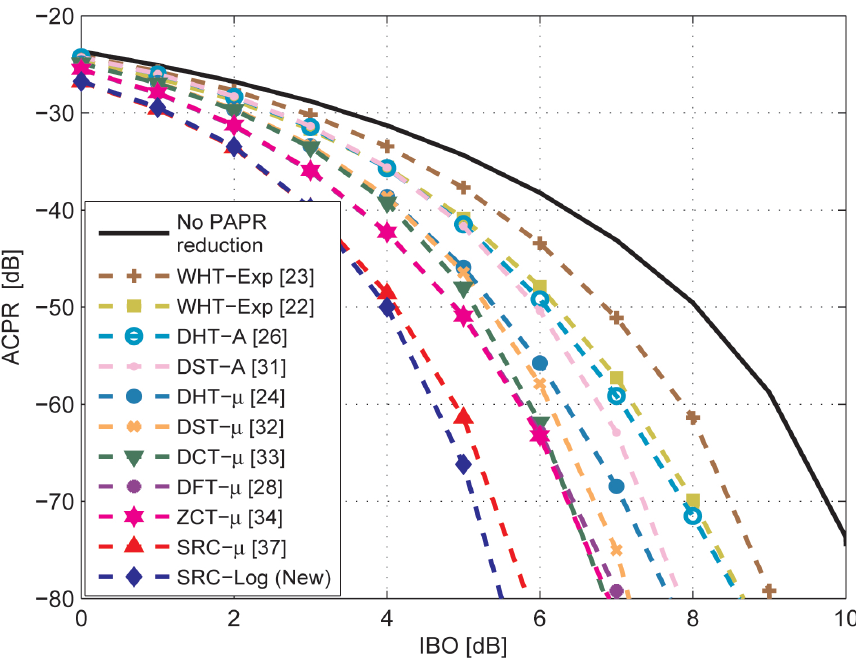
Figure 11. ACPR comparison of the proposed SRC-Log and the previous precoding- companding techniques, in addition to the cases of OFDM w/o PAPR reduction in the presence of